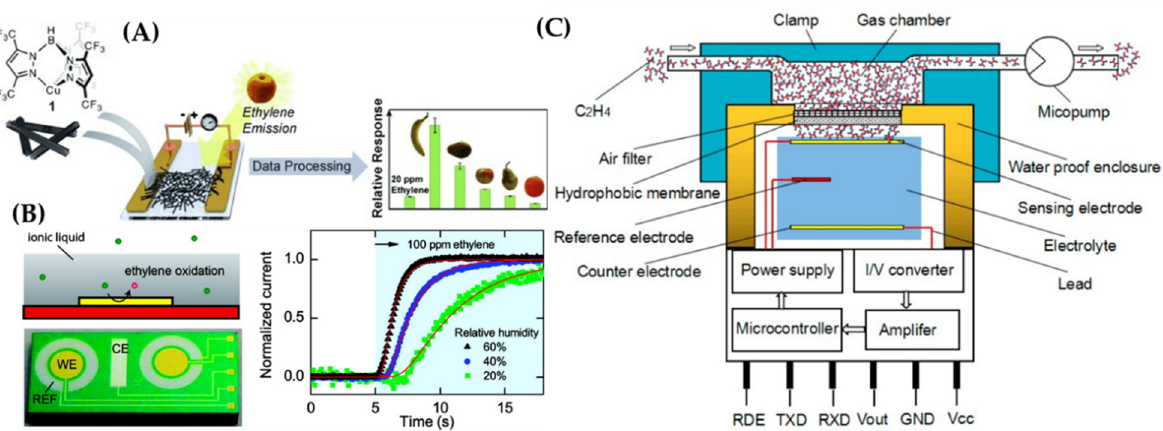
Figure 12. ( A ) Schematic diagram of an ethylene chemoresistive sensor, reproduced with permission from [73]. ( B ) Schematic diagram of the ethylene sensing mechanism, reproduced with permission from ref. [74]. ( C ) Schematic diagram of a smart electrochemical ethylene sensor, reproduced from [75]. Table 4. Comparison summary of intelligent systems in fruit packaging container.